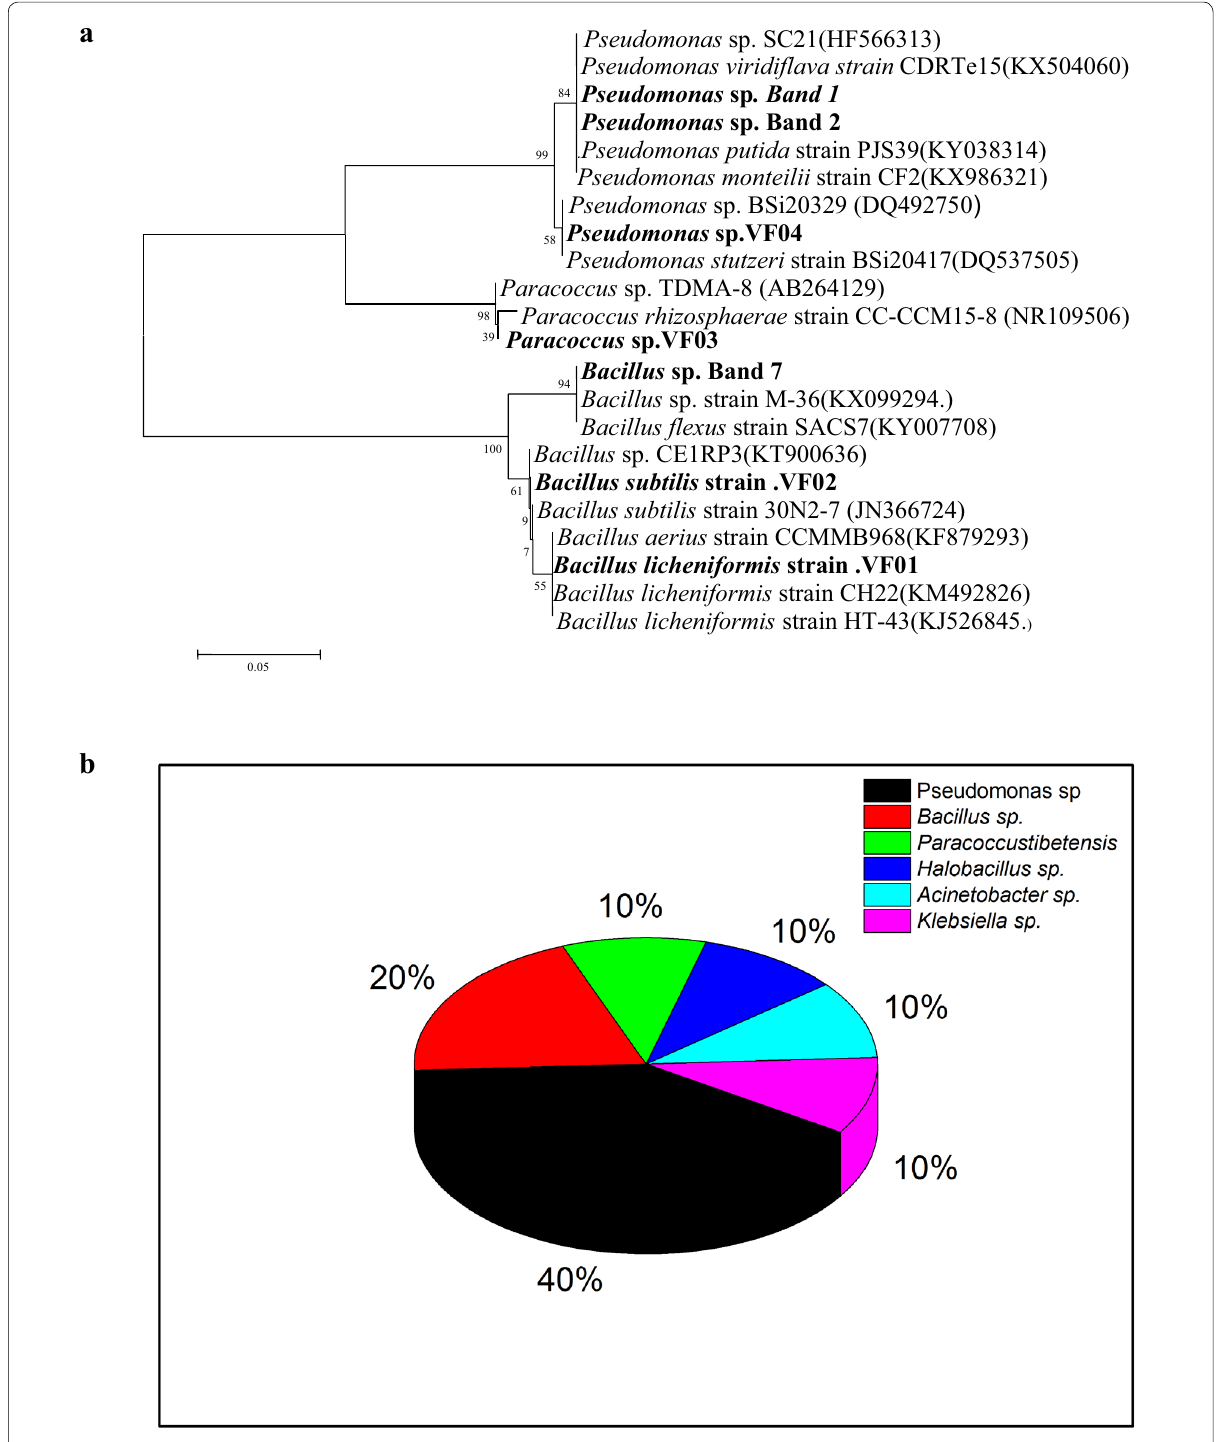
Fig. 3 a Phylogenetic tree with cut bands: Band 1, Band 2, Band 7, Band 10; isolated strains: VF01, VF02, VF03, VF04; and their closest relatives derived from GenBank data based on 16S rRNA gene analysis. b The percentage of “community” in this kind of